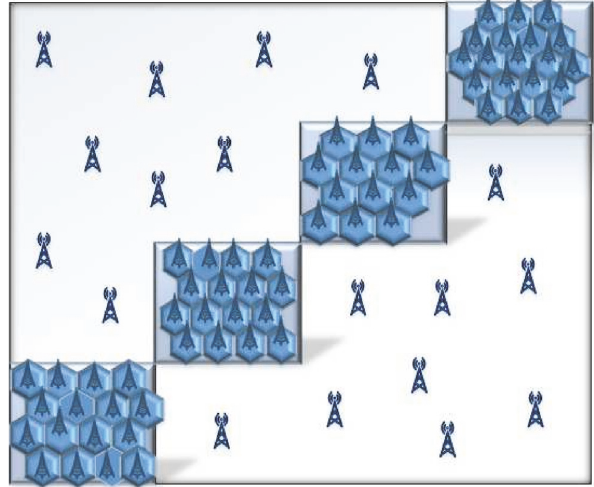
Figure 4: Convergence graphs.